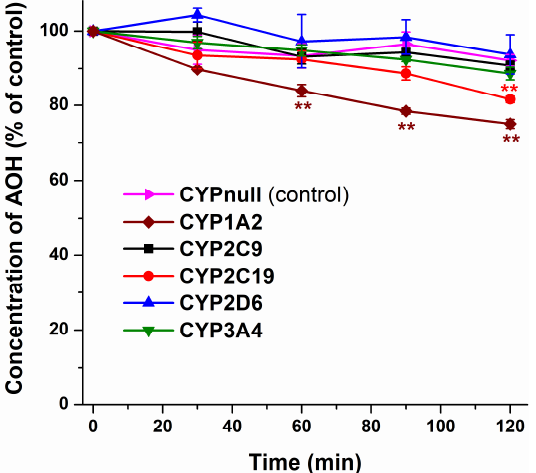
Figure 2. Time-dependent changes in the concentrations of AOH (5 μM) in the presence of the different CYP isoenzymes (see experimental details in 2.3; n = 3; ** p < 0.01). Statistical evaluation was performed compared to the incubation with the same amount of CYPnull (15 mg/mL), which is a permeabilized and stabilized dried yeast powder (produced using an empty vector) and processed identically to CypExpress Cytochrome P450 products.